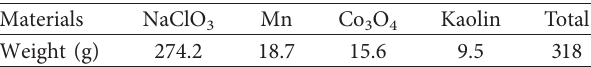
Table 2: Quality of the sample required for the experiment. Materials NaClO 3 Mn Weight